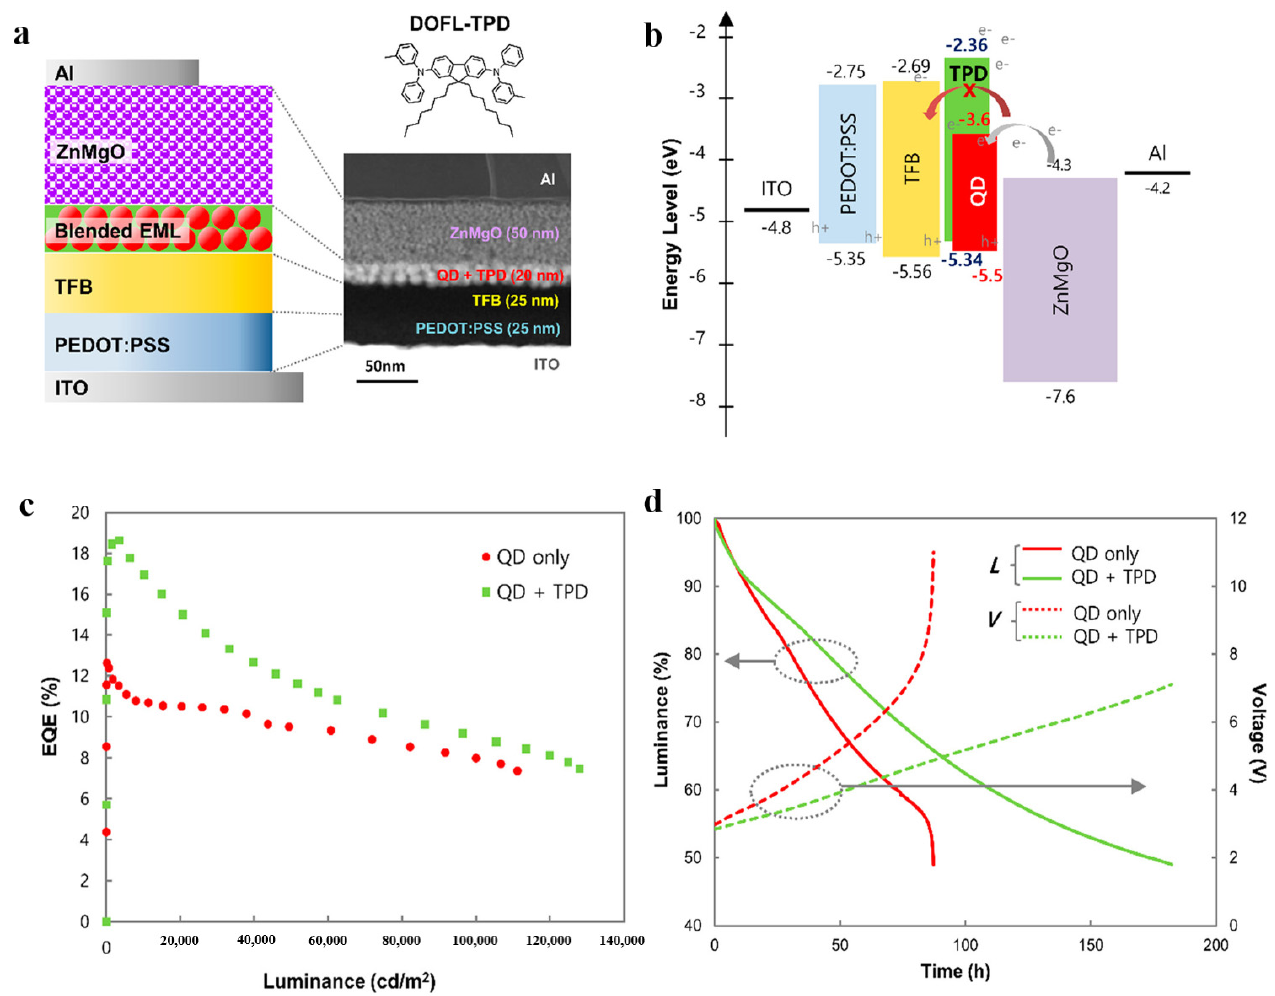
Figure 12. ( a ) Schematic device illustration (left), molecular structure of DOFL − TPD, and cross − sectional TEM image of QLEDs with DOFL − TPD blended QDEML (right). ( b ) Energy diagram of QLED comprising DOFL − TPD blended QDEML. ( c ) EQE − Luminance characteristics for the QLEDs with QD − only EML and DOFL − TPD blended QDEML. ( d ) Operational lifetime of QLEDs with QD − only EML and the blended QDEML measured at initial luminance of 5750 cd/m 2 . Reprinted with permission from Ref. [25]. © 2021, American Chemical Society.